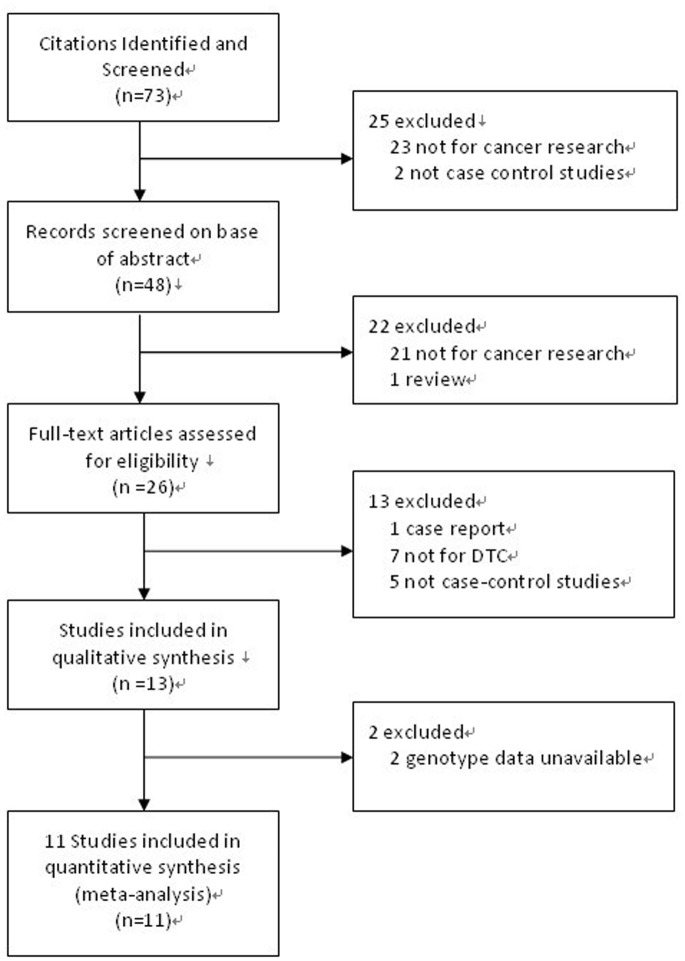
Flow diagram summarizing the search strategy.